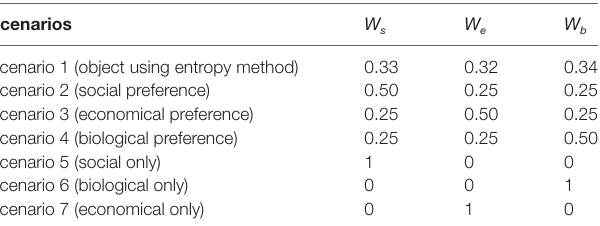
TABLE 5 | Weight of relevant dimension indicators under different decision preferences.